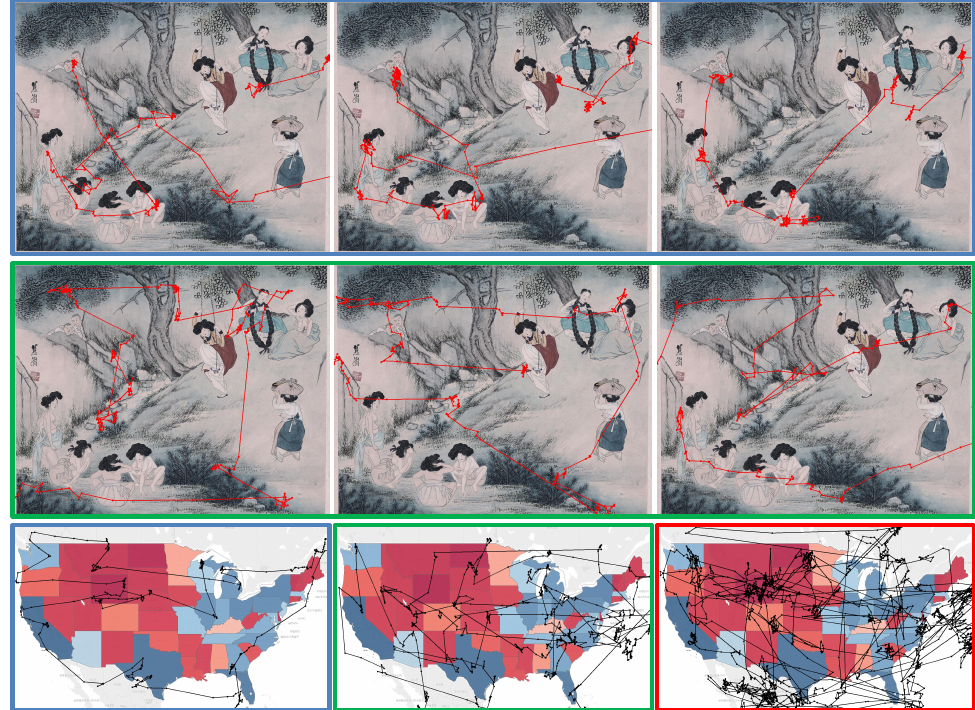
Figure 6. Comparison of gaze data for three participants. The scanpath of each participant is identified by blue, green, and red box frame